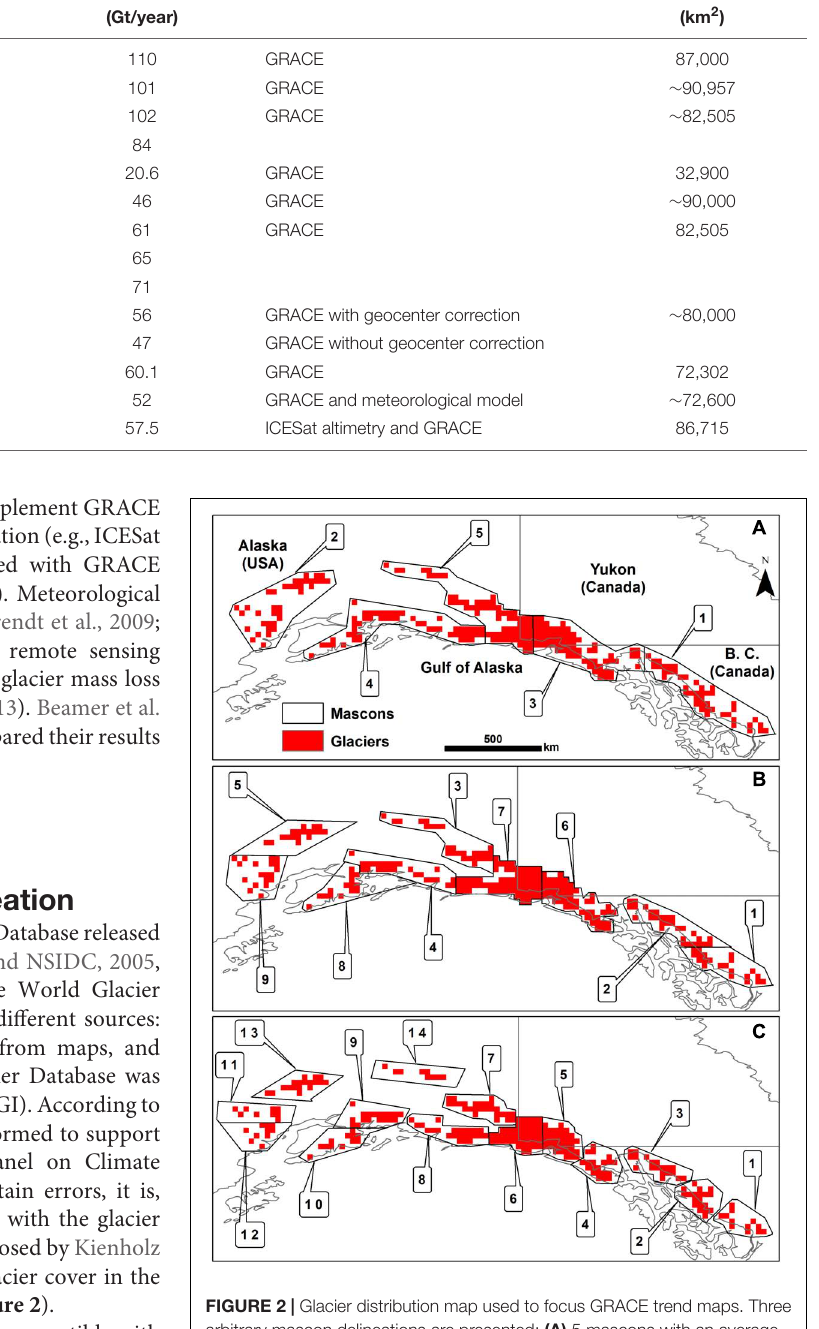
FIGURE 2 | Glacier distribution map used to focus GRACE trend maps. Three arbitrary mascon delineations are presented: (A) 5 mascons with an